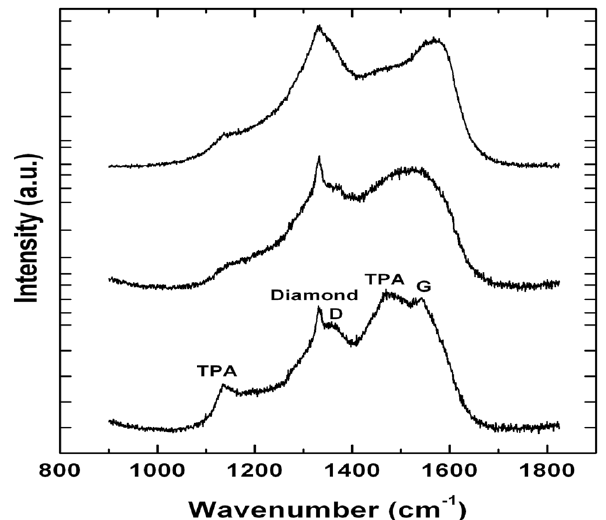
Figure 3. Raman spectra from NSD films grown on silicon using GC1 (bottom), GC2 (middle), and GC3 (top) gaseous chemistries are shown. A low level of amorphous carbon is apparent from the middle, top